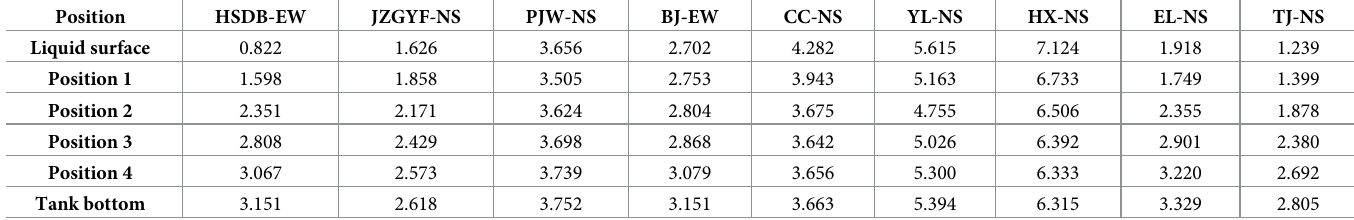
Table 9. The maximum hydrodynamic pressure of the tank wall under unidirectional main seismic motion with 1.0 m/s 2 peak acceleration for A-50% condition (KPa). Position HSDB-EW